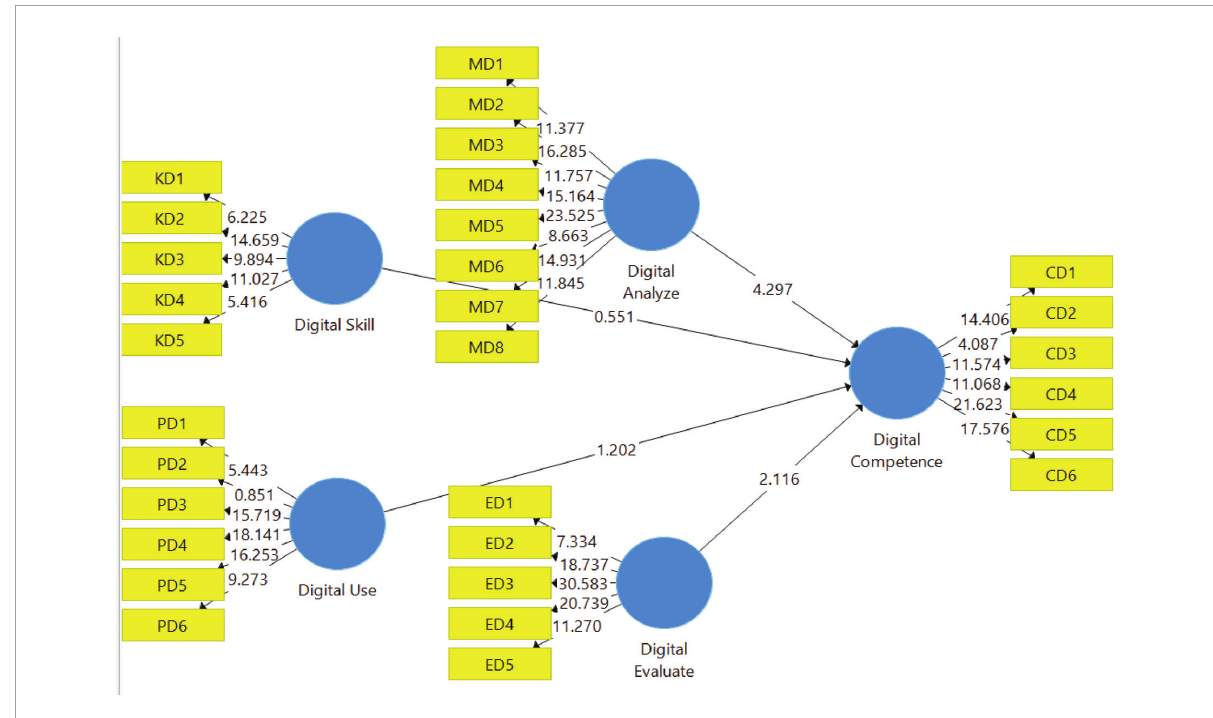
FIGURE4 Digital competence analysis